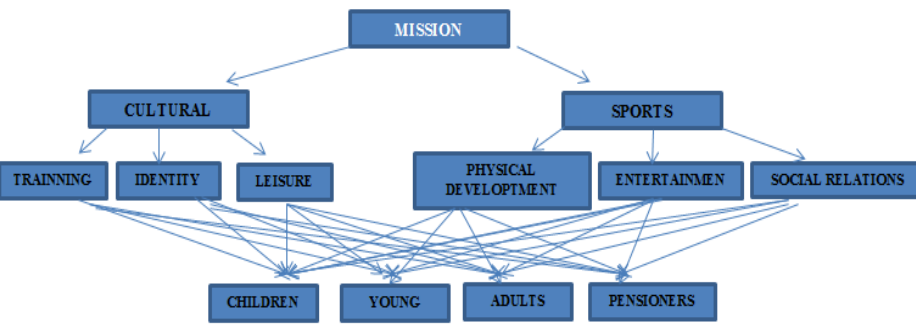
Figure 5. Hierarchy of the Cadrete experience (source: the authors)